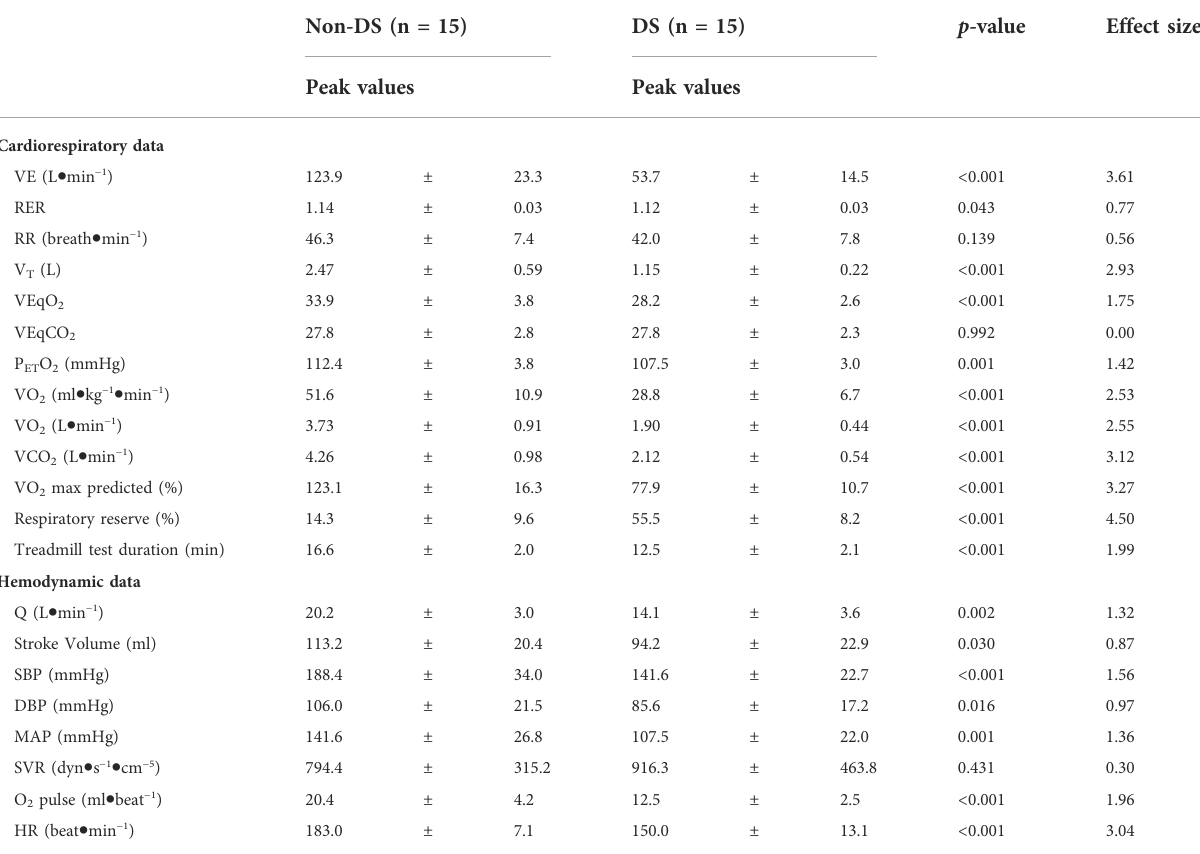
TABLE 3 Participants ’ peak cardiorespiratory and hemodynamic